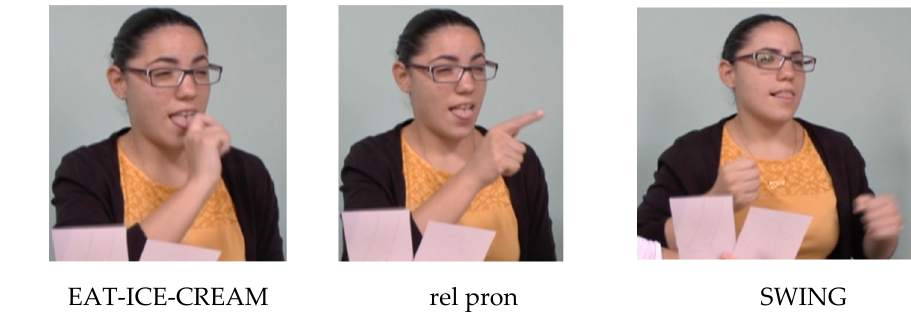
Figure 1. ‘The girl who is eating ice cream is swinging’. The relative clause is marked nonmanually by squint and head movement forward to the end of the clause, and manually by the clause-final relative pronoun pointing sign. The space indicates a prosodic break between the relative clause and the rest of the sentence (Dachkovsky 2020). Pictures courtesy of the Sign Language Research Lab, University of Haifa.